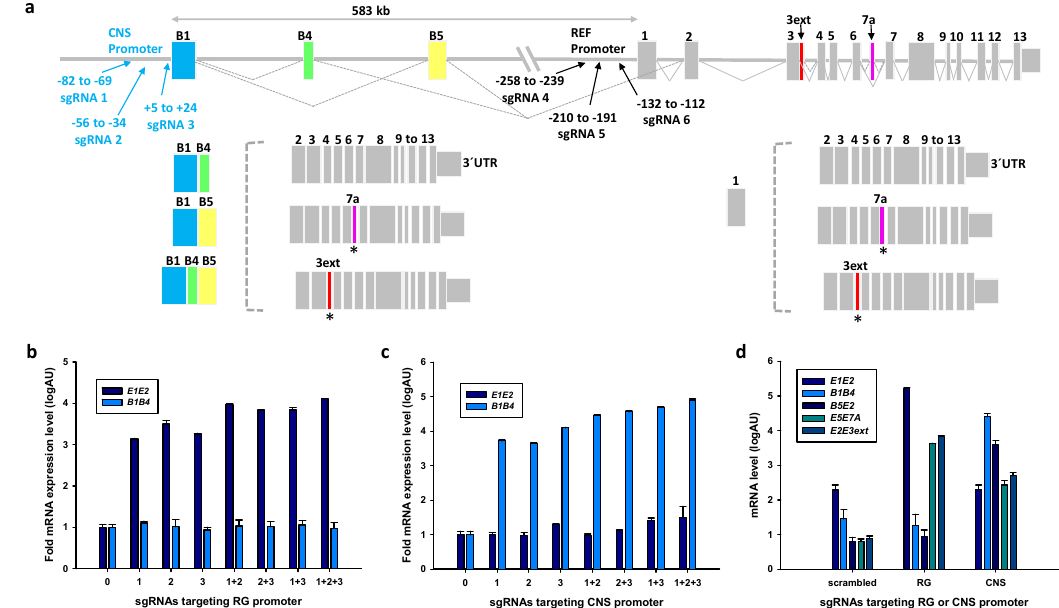
Figure 1. The CNS and reference gene (RG) promoters are selectively activated by specific single guide RNAs (sgRNAs) designed to target them. ( a ) Schematic representation of the PPARGC1A locus showing the CNS and RG promoters (top), locations of sgRNAs used for transfections; CNS-specific exons B1 , B4 and B5 in color; the structure of the RG is displayed on the right; CNS-specific transcripts and RG transcripts are shown below; pink or red lines refer to alternatively spliced transcripts encoding stop codons in exon 7A or in an extension of exon 3, respectively. ( b , c ) Selective effects of individual sgRNAs targeting the RG or CNS promoters on transcription initiation; individual sgRNAs or their mixtures were transfected into clonal SH-SY5Y cells expressing CRISPR-associated deactivated (dCas9) protein fused to the tripartite transcriptional activator VPR and levels of E1E2 and B1B4 transcripts selective for RG or CNS promoter activation were measured by qRT-PCR 36 h after transfection. Log-fold levels are expressed relative to transcript levels of the clonal cells transfected with scrambled sgRNA. Interactions of all sgRNA mixtures shown were significant ( p < 0.001) when the use of three, two, or one sgRNA was compared. ( d ) Effects of sgRNA transfections on CNS-specific and RG transcript levels and levels of transcripts encoding truncated isoforms and initiated at either promoter.